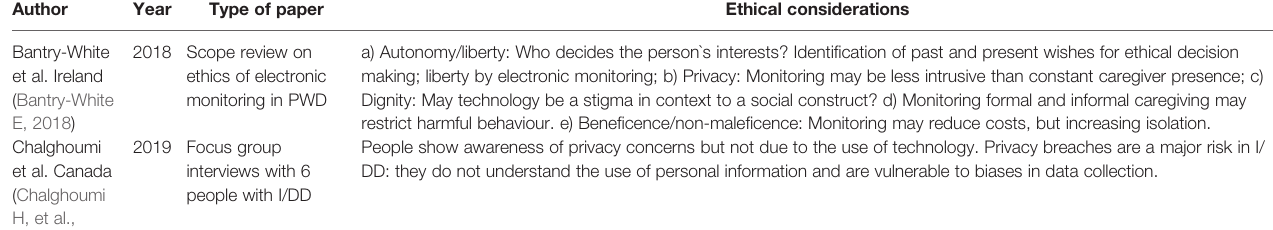
TABLE 7 | Review and opinion articles on ethical considerations in sensing technology for people with dementia or intellectual and developmental